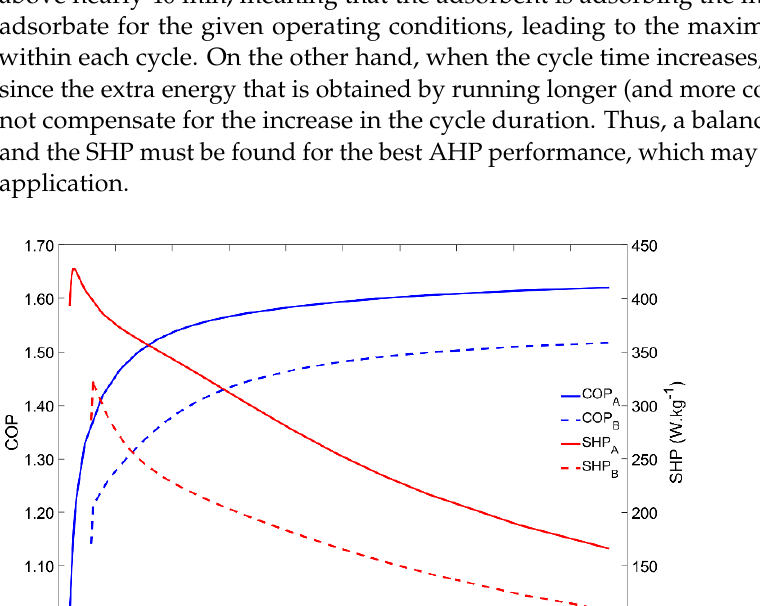
Figure 5. Adsorber performance as a function of the regeneration temperature for scenarios A and B.